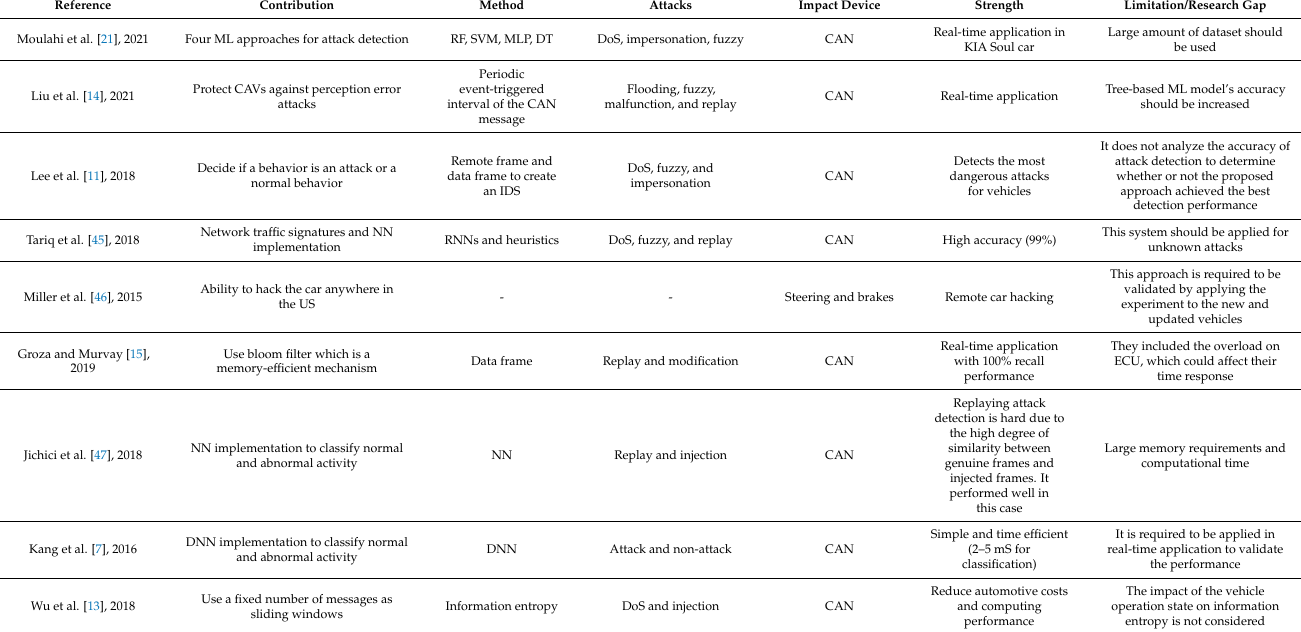
Table 1. Summary of the state-of-the-art of intrusion detection techniques in